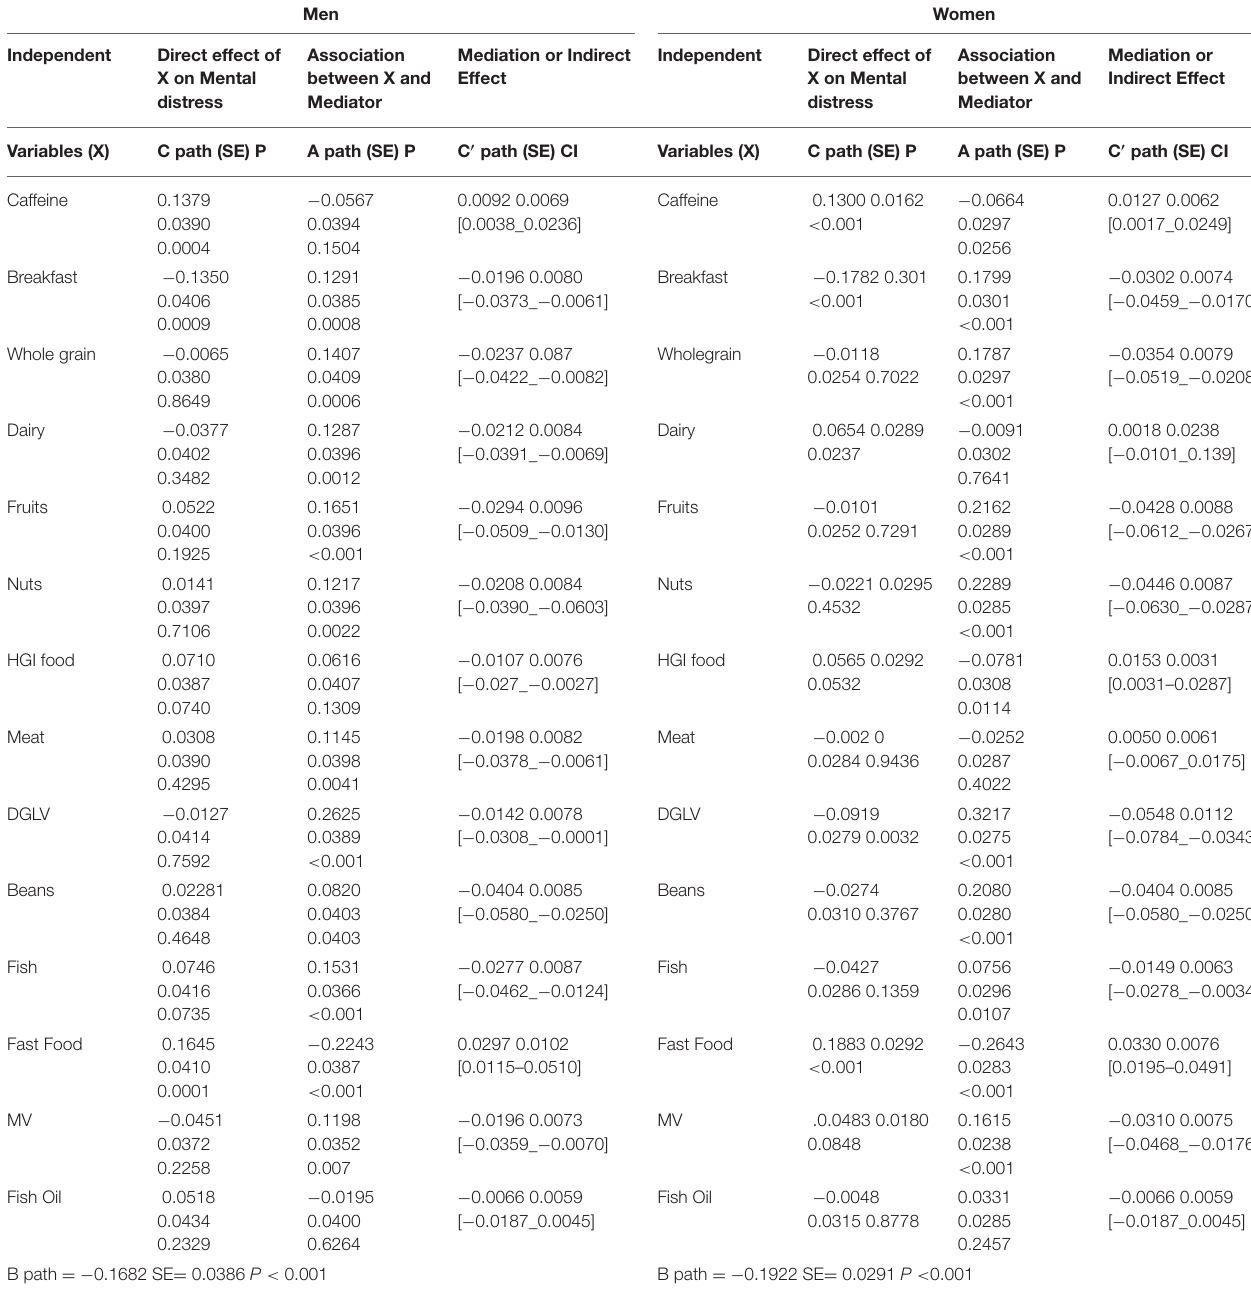
TABLE 4 | Mediation regression analysis results based on gender